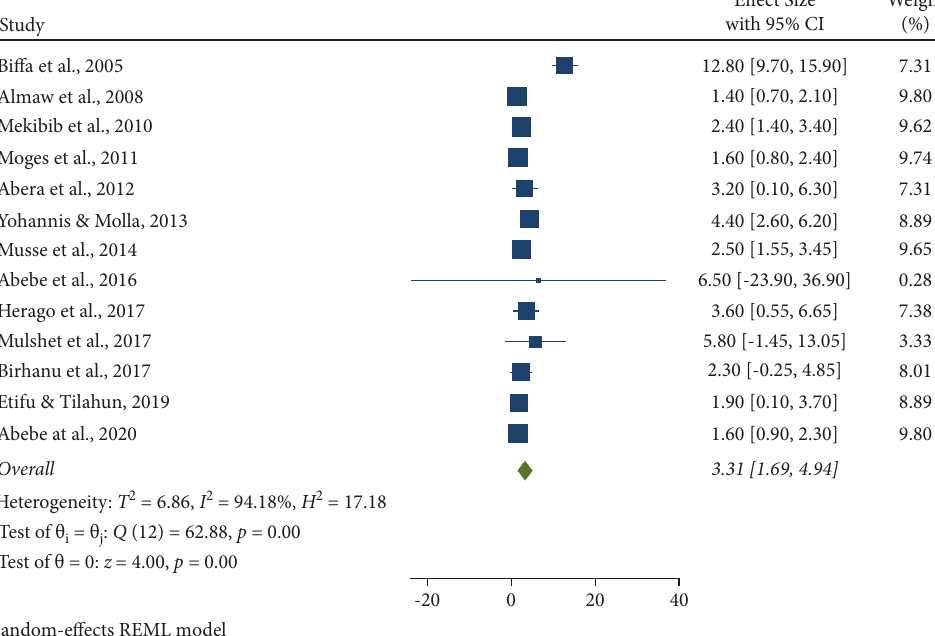
Figure 11: Parity as an associated risk factor for mastitis among dairy cows.